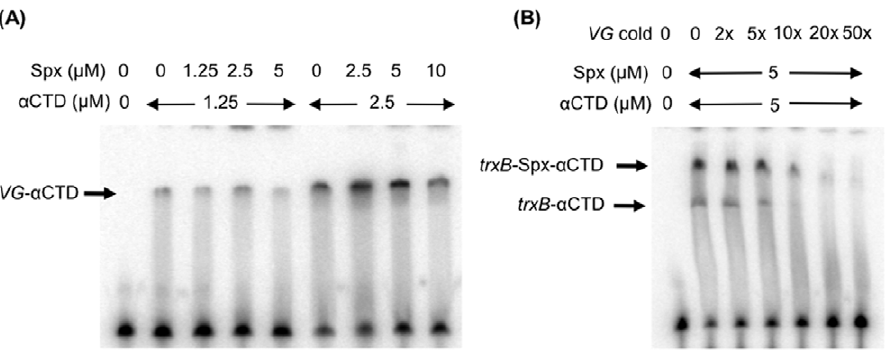
Figure 9. Interaction of a CTD and Spx with the spoVG promoter carrying AT-rich upstream sequences. (A) The radiolabeled spoVG probe was generated as described in Figure 7. The spoVG - a CTD complex is marked with an arrow. (B) Competition of the trxB - a CTD and trxB -Spx- a CTD complexes with spoVG was examined by the addition of a 2- to 50-fold excess of cold spoVG probes.